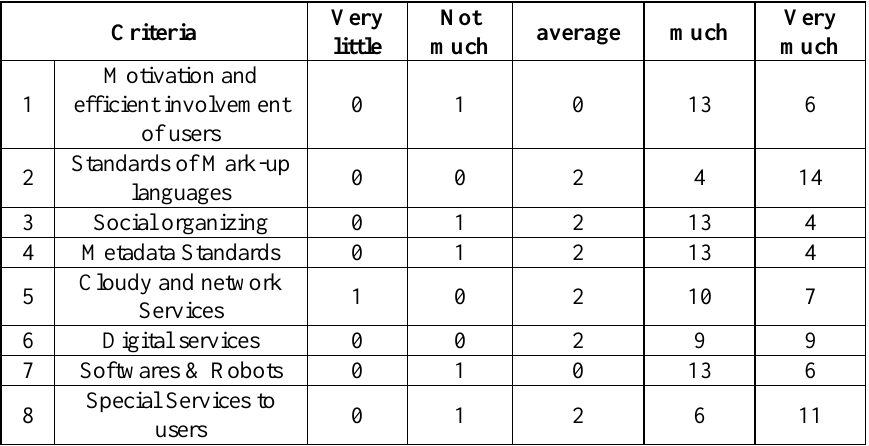
Table 7. Results of counting the answers of the poll's third stage.